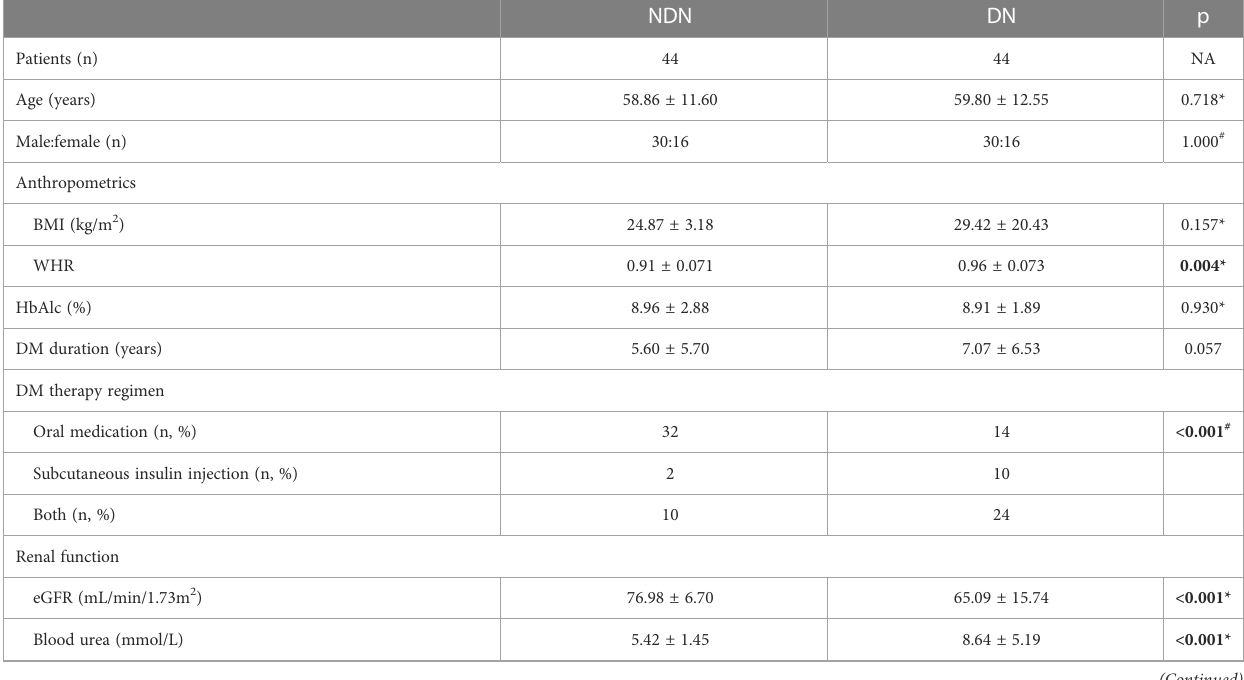
TABLE 1 Patient